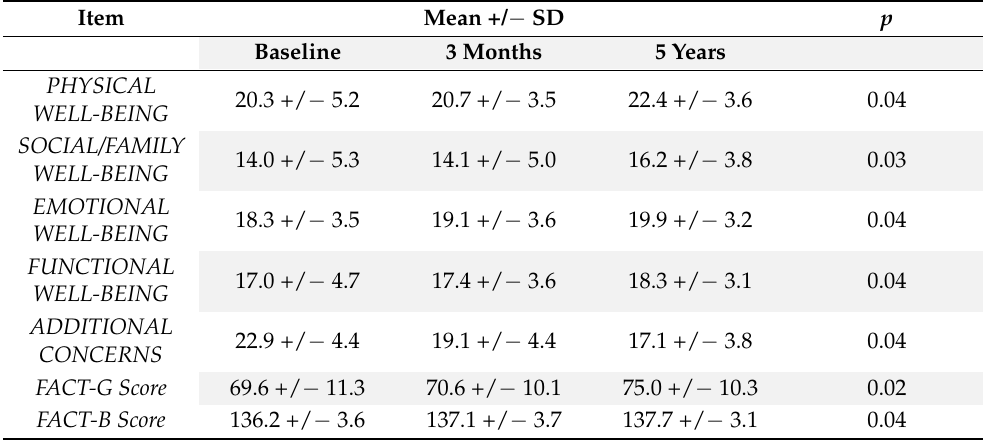
Table 5. FACT (Functional Assessment of Cancer Therapy)